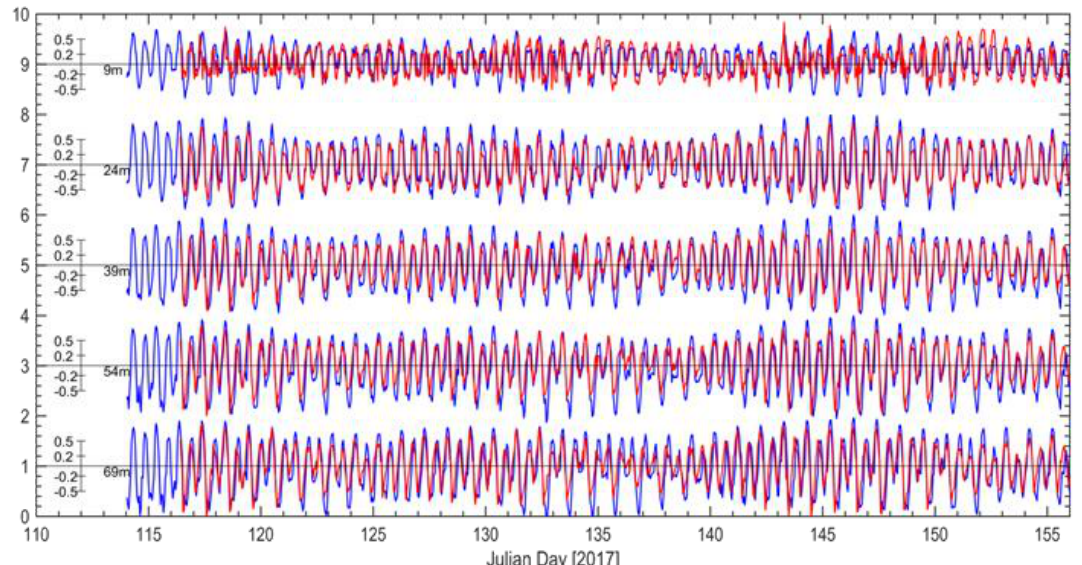
Figure 10. Comparisons of predicted (blue) and observed (red) velocities for different depths at the Bridge ADCP station (example).